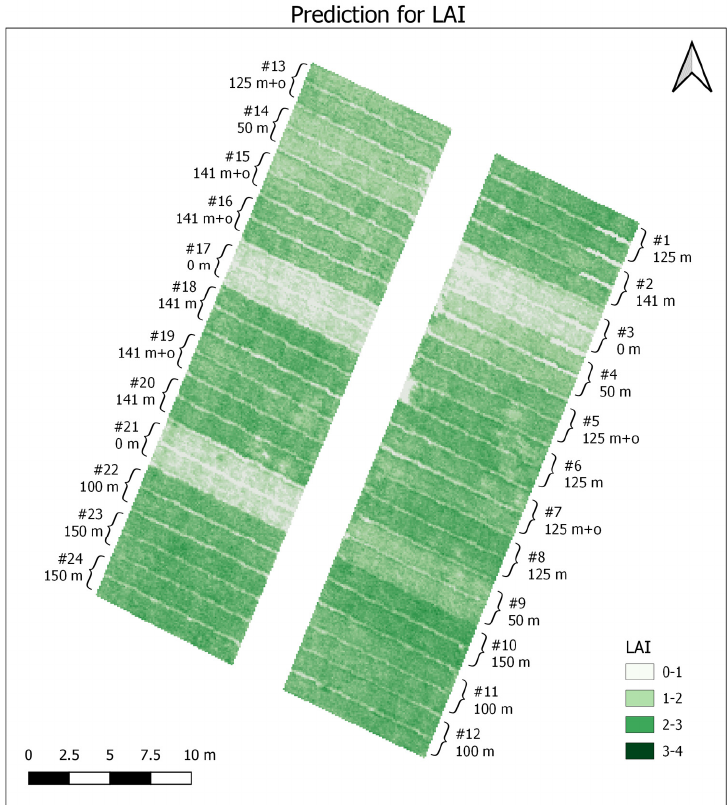
Figure 9. Spatial prediction for LAI based on PLSR model.